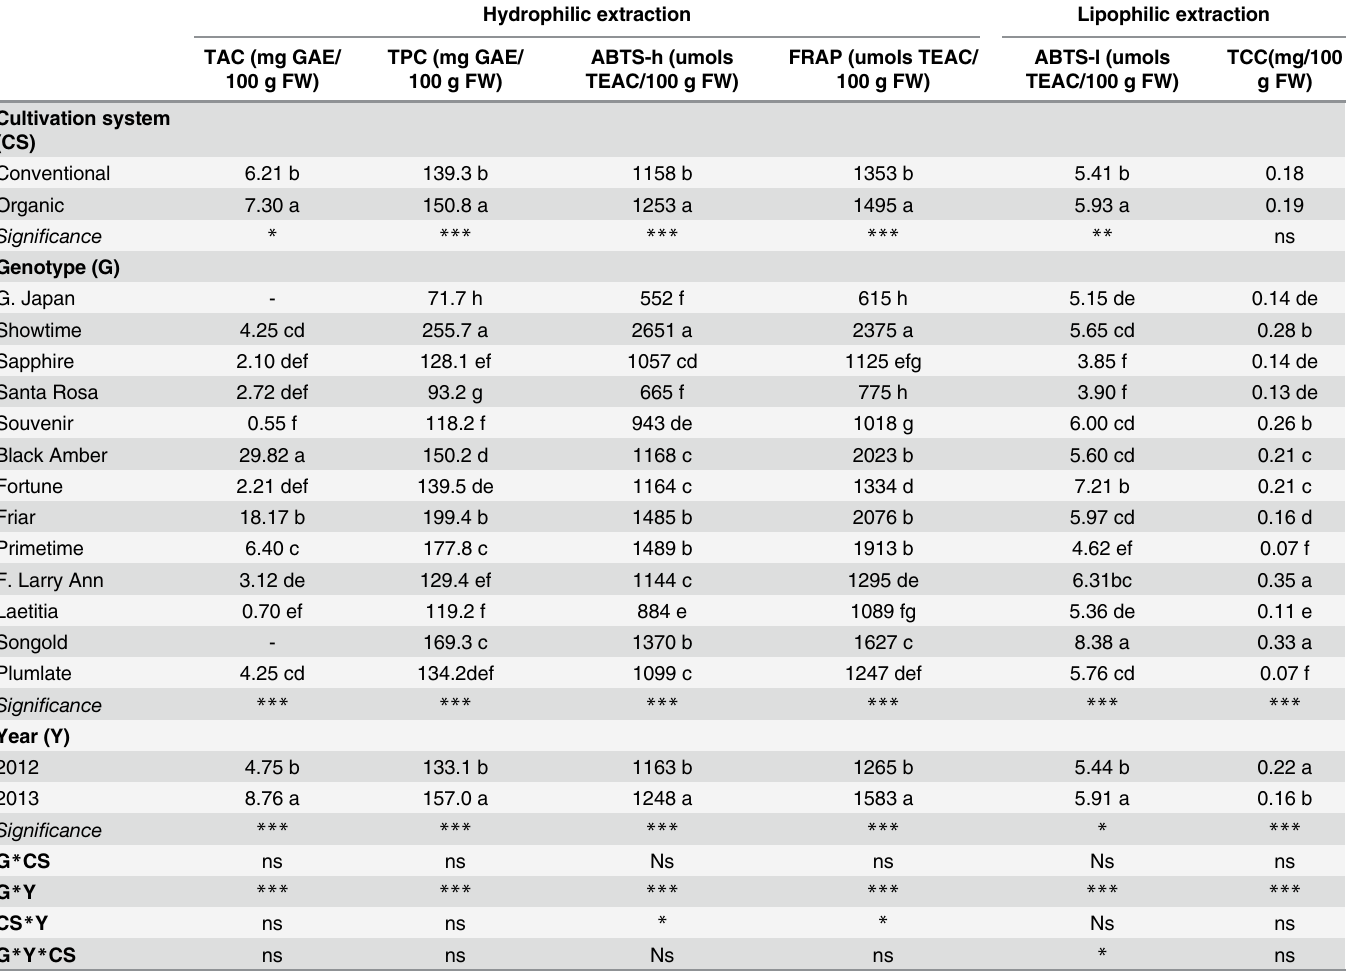
Table 2. Effects of cultivation system, genotype and year of harvest on the anthocyanins, polyphenols, antioxidant capacity, and carotenoids of plums. Hydrophilic